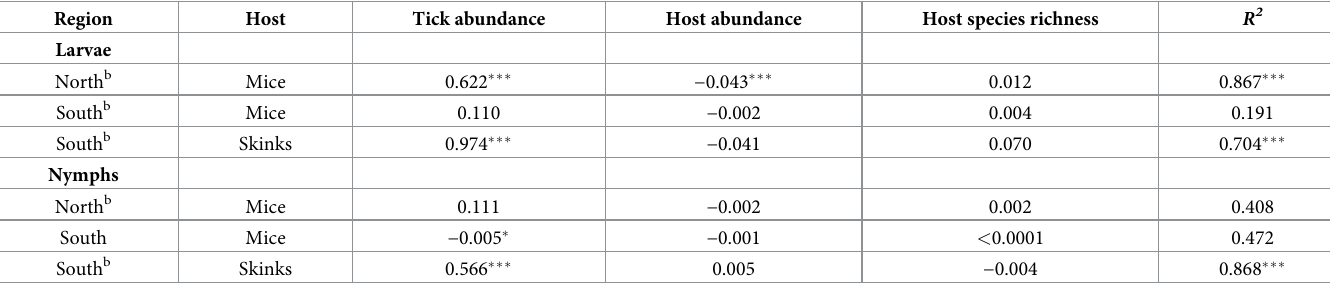
our northern and southern sites by applying general linear models (GLMs) to assess the effects of overall tick abundance, overall host abundance, and host species richness on mean numbers of ticks per individual host animal. GLM analyses to assess log numbers of ticks per mouse at all sites, with “North versus South” as a class variable, found significant differences between northern and southern sites for both larvae ( p = 0.0002) and nymphs ( p < 0.0001), so we ana- lyzed northern sites separately from southern sites in Table 2. Overall tick abundance (the mean number of ticks collected from all hosts per sample week, Fig 2H) predicted the number Table 2. Factors affecting the number of ticks per host animal a